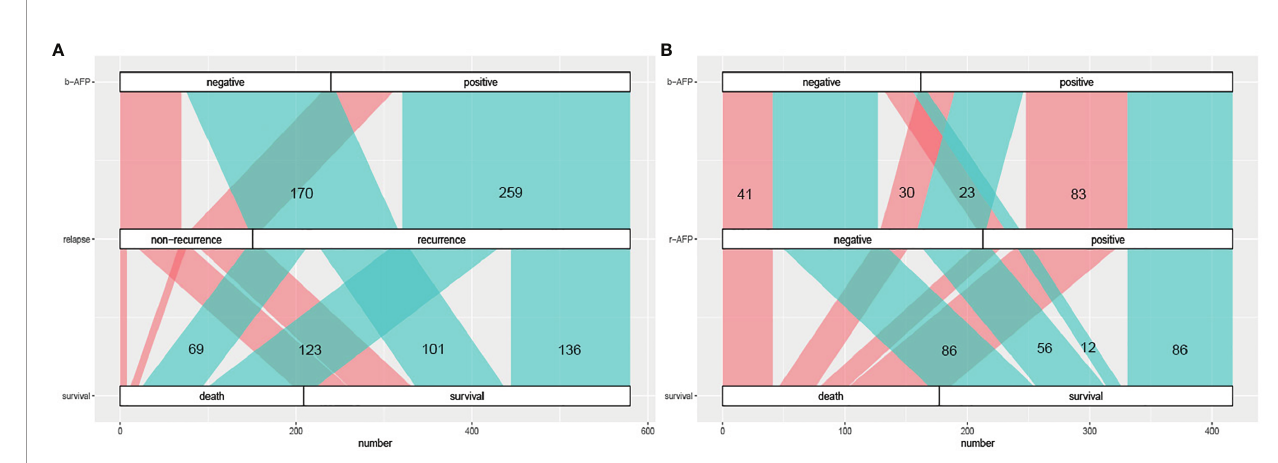
FIGURE 2 | The Sankey diagram of correlation between AFP prognosis. (A) the correlation between AFP at baseline and prognosis including recurrence and long- term survival; cyan part represents the recurrence group and coral part represents the non-recurrence group. (B) the correlation between AFP alteration (at baseline and relapse) and long-term survival; cyan part represents the survival group and coral part represents the death group. AFP, alpha fetoprotein; b-AFP, AFP at baseline; r-AFP, AFP at